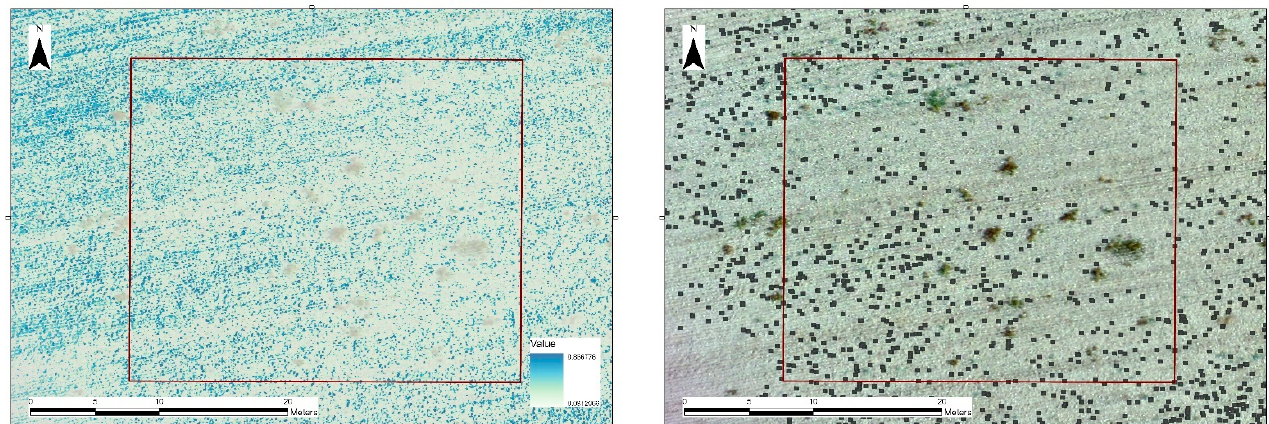
Figure 5. The probability map indicates areas with a potential potsherd concentration in Area 20 ( left ) using the random forest classifier and the final binary classification outcomes ( right ).